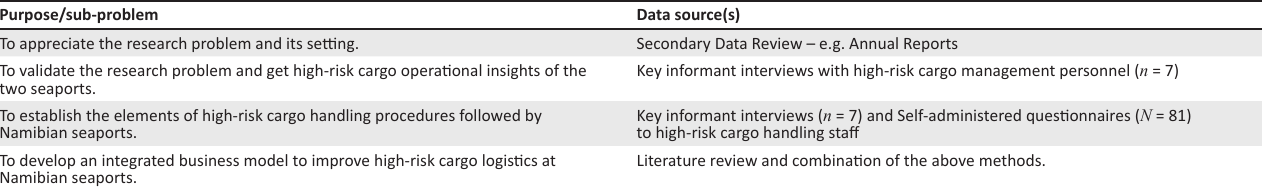
TABLE 1: Justification for using multiple data collection methods for the study.